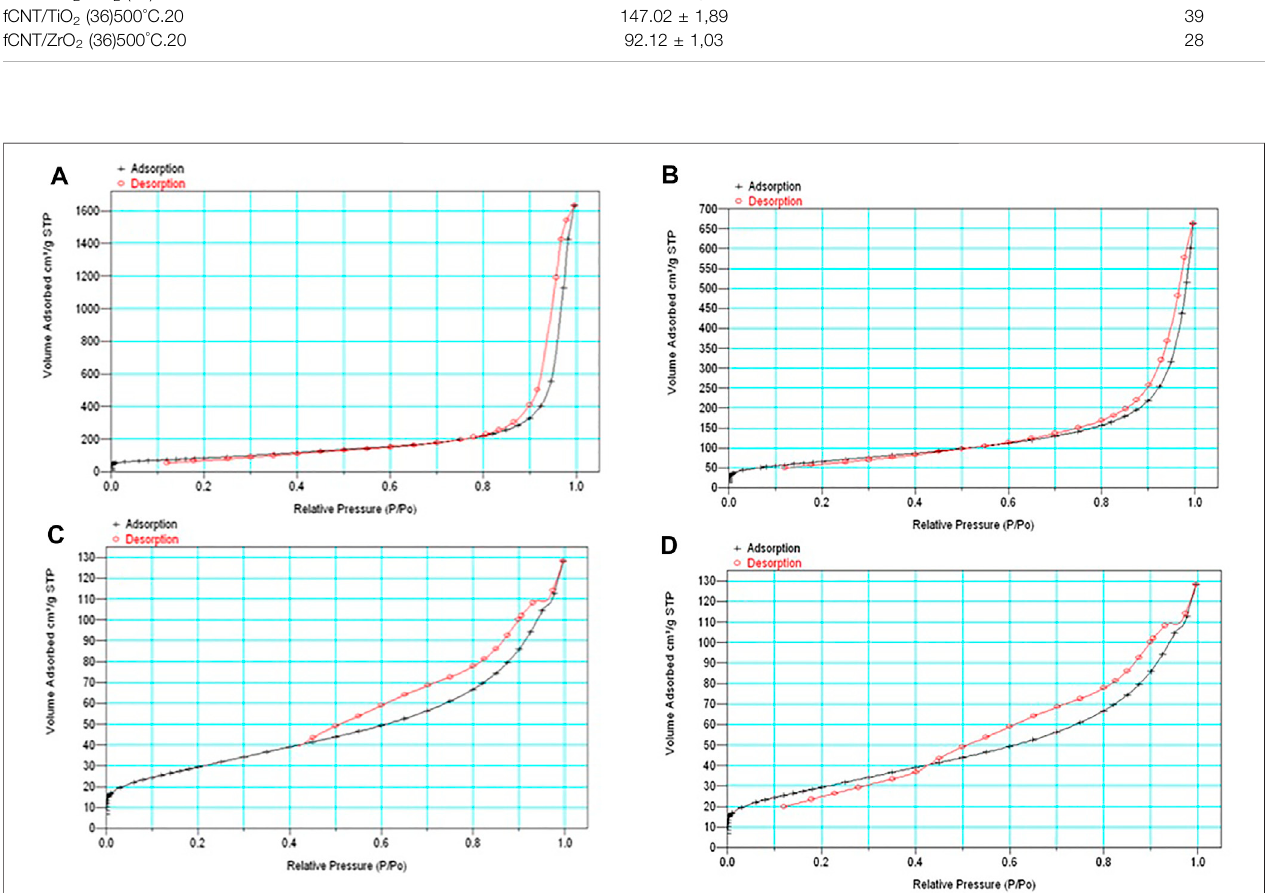
Frontiers in Chemistry |